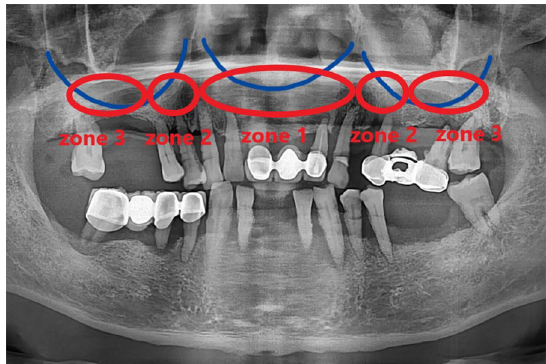
Fig. 1 A schematic of three zones of